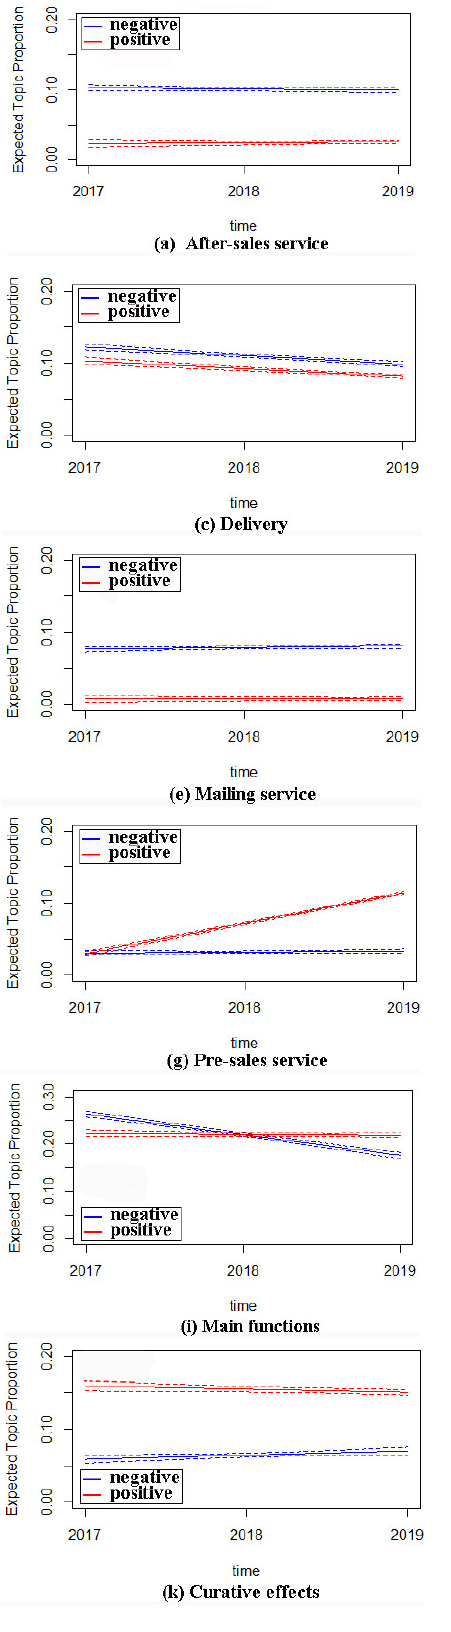
Figure 4. Moderating effects of time.